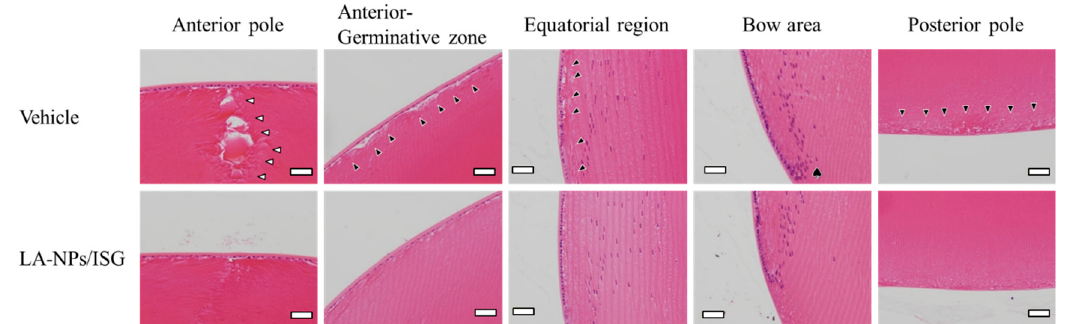
Figure 5. Changes in the lens structure of 12-week-old SCR-N repetitively instilled with LA-NPs/ISG. The repetitive instillation was performed twice per day from six weeks of age. White arrowhead, structure collapse of Y-shaped sutures. Black arrowhead, slight space and structure collapse. ♠ , multi-layered cells. Scale bar shows 50 µm. Vehicle is solution consisting of BAC, mannitol, HPCD, and MC. The space and structure collapse in the lens of SCR-N with aging was attenuated by the instillation of LA-NPs/ISG.